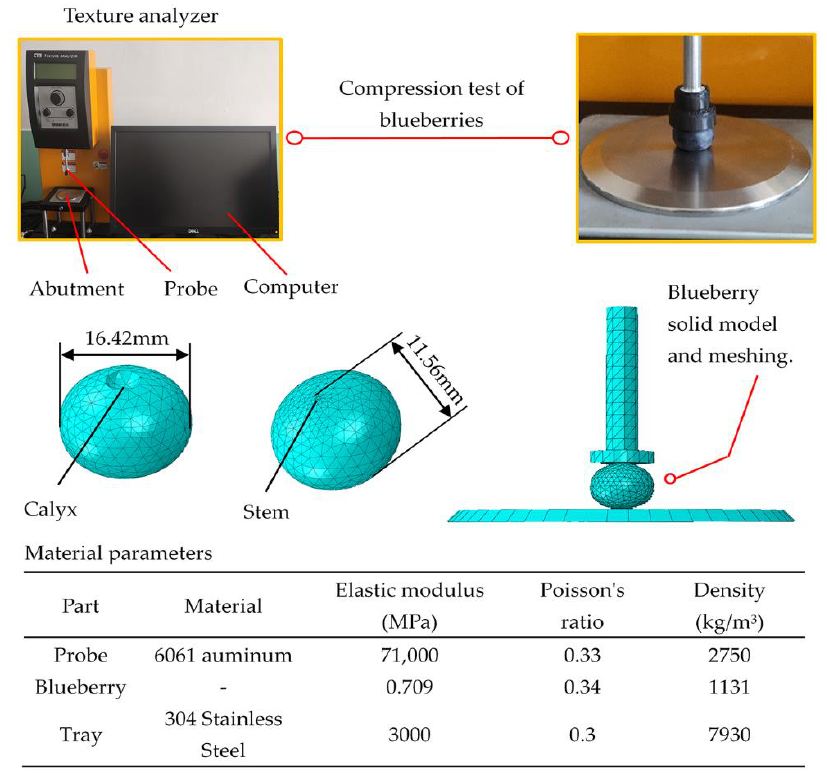
Figure 1. Blueberry compression and finite element